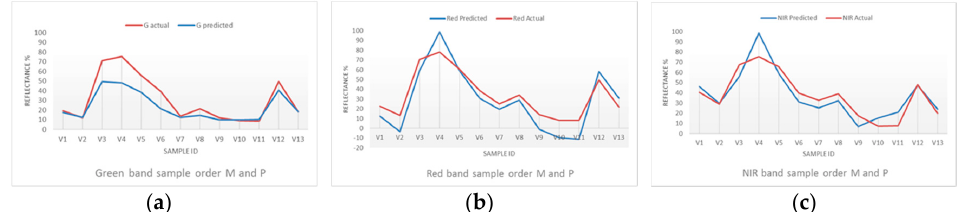
1 U test: no statistical difference in distributions at 95% confidence level. Plots of the measured and Spectralon EL2 equation-predicted mean spectral reflectance values of the 13 validation samples are shown in Figures 12 and 13 below.